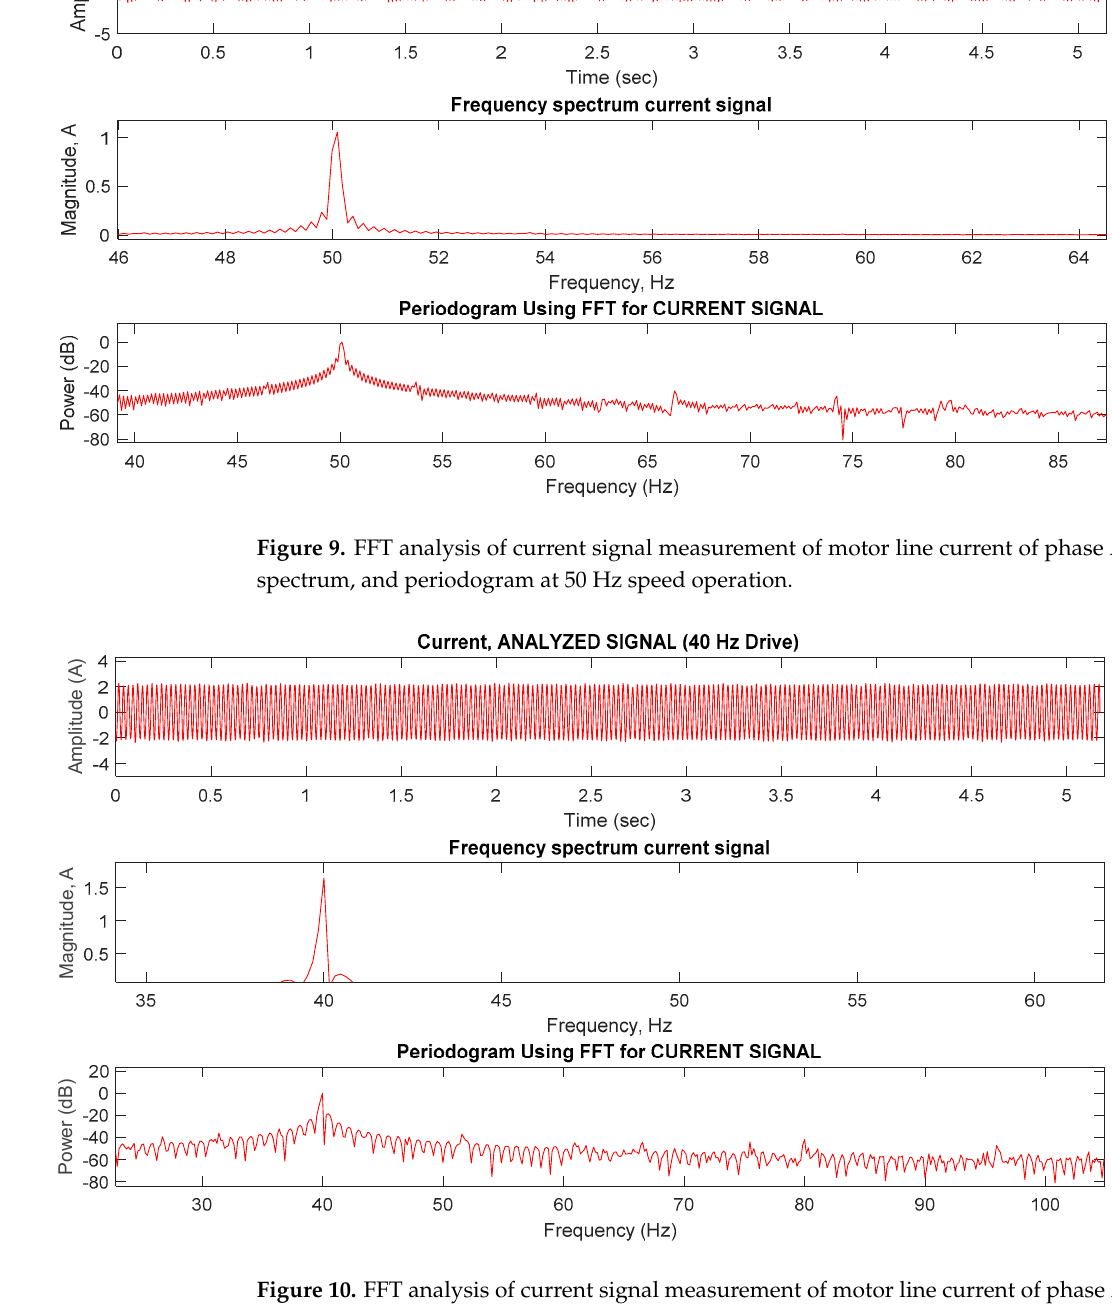
Figure 11. FFT analysis of current signal measurement of motor line current of phase A, frequency spectrum, and periodogram at 30 Hz speed operation.